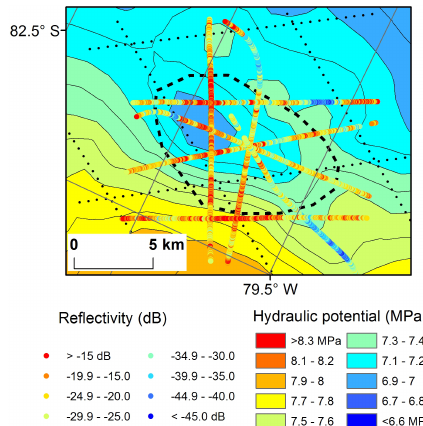
Fig. 5. Received RES strength (in dB) from basal reflections along RES lines defined in Fig. 1 over and around Institute E2 (see Fig. 4b for location). The RES lines are superimposed onto the ice sheet hydro-potential (as in Fig. 4b). Also shown is the outline of Institute E2, as proposed by Smith et al. (2009) (black dashed